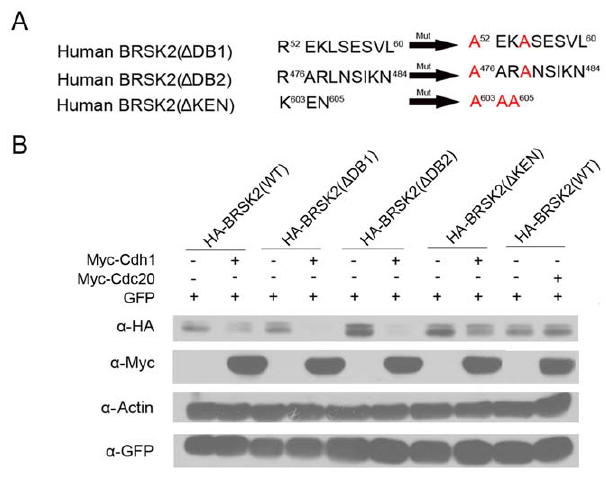
Figure 5. The KEN box is essential for BRSK2 degradation. The same amount of wild type or various mutant HA-BRSK2 expression constructs were co-transfected with (–) or without ( + ) Myc-Cdh1 or Myc- Cdc20 plasmid into HeLa cells. The protein levels of BRSK2 and Cdh1 were determined by Western blotting (WB) with anti-HA and anti-Myc antibodies, respectively. The pEGFP-C1 expression construct was